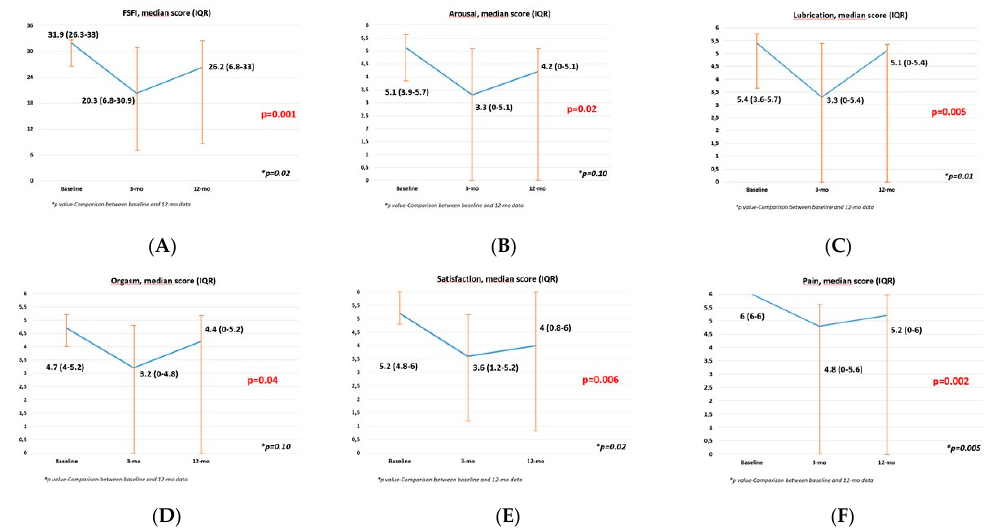
Figure 2. Graphs showing EORTC-QLQ-C30 and EORTC-QLQ-BLM30 questionnaire items displaying statistical significance according to the Friedman test. ( A ) Quality of Life / Global health status; ( B ) Emotional functioning; ( C ) Physical functioning; ( D ) Urinary symptoms and problems.